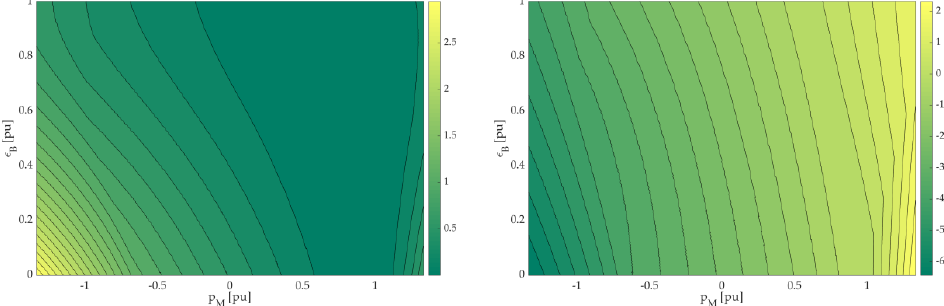
Figure 7. The optimal φ B ( left ) and φ ST ( right ) loci (in $/h) on the ( p M , ε B ) plane.